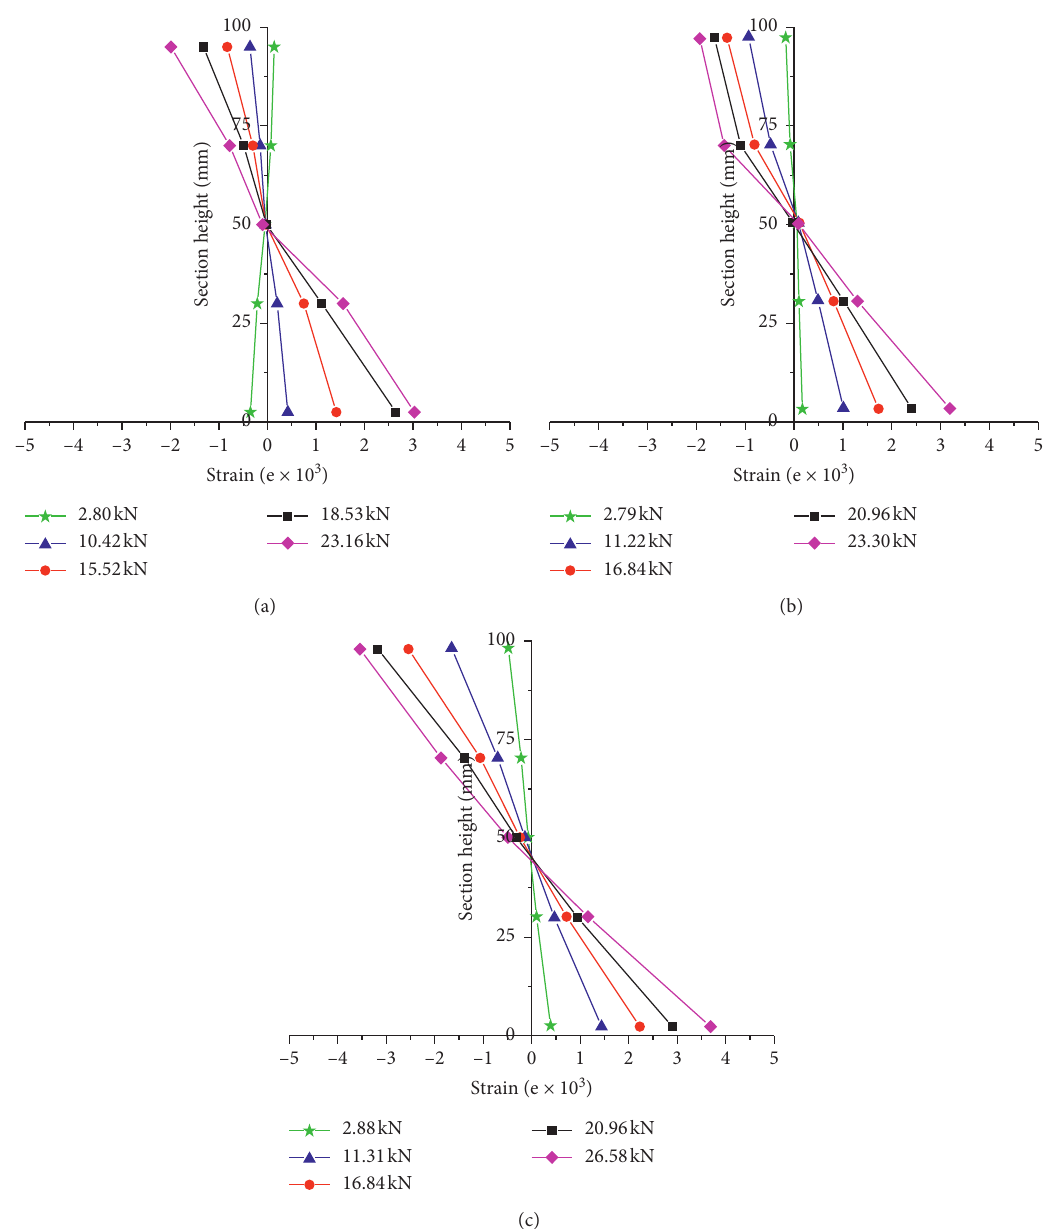
Figure 13: Section-strain curve of test beams in group B. (a) SPF-1.2. (b) SPF-2.2. (c)